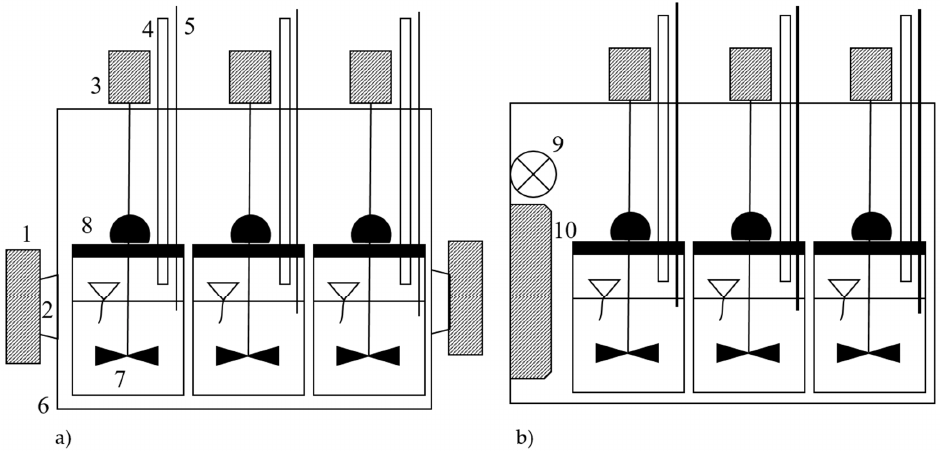
Figure 1. Design of experimental stations: ( a ) microwave heating system (electromagnetic microwave radiation (EMR)); ( b ) convection heating system (CH) (1—magnetron; 2—wave-guide; 3—agitator drive; 4—pressure measurement and biogas collection; 5—temperature sensor; 6—steel cabinet; 7—agitator; 8—model fermentation tanks; 9—fan; 10— convector).